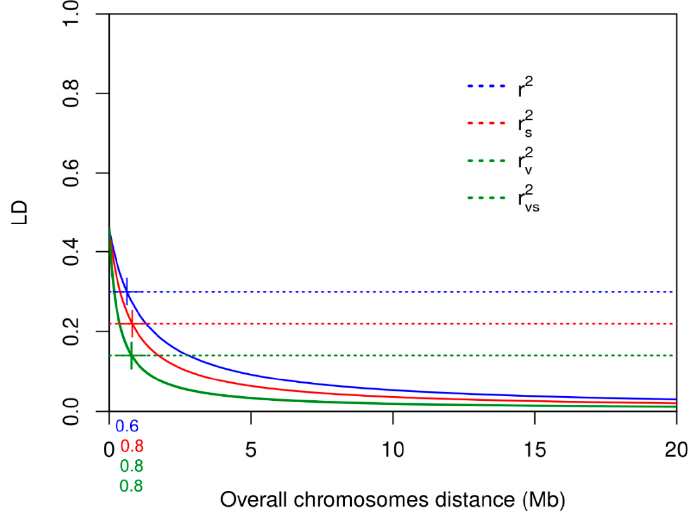
Figure 3. Linkage disequilibrium decay levels over all chromosomes calculated using the standard r 2 coefficient and the r 2 measure corrected for population structure (r s2 ), kinship (r v2 ) and both population structure and kinship (r vs2 ).